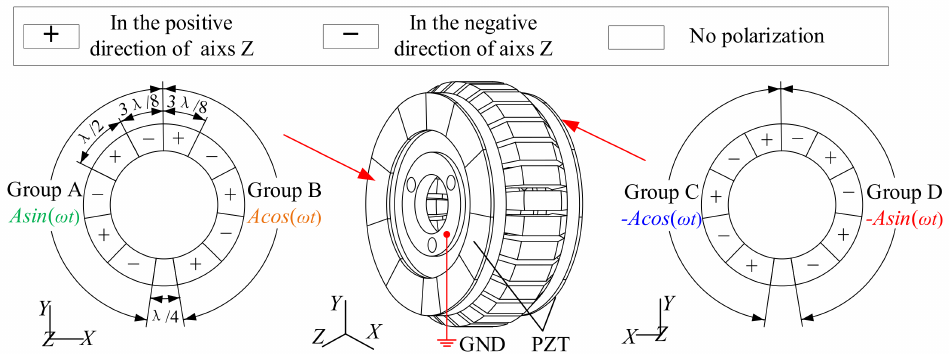
Figure 4. Polarization pattern and distribution of PZT